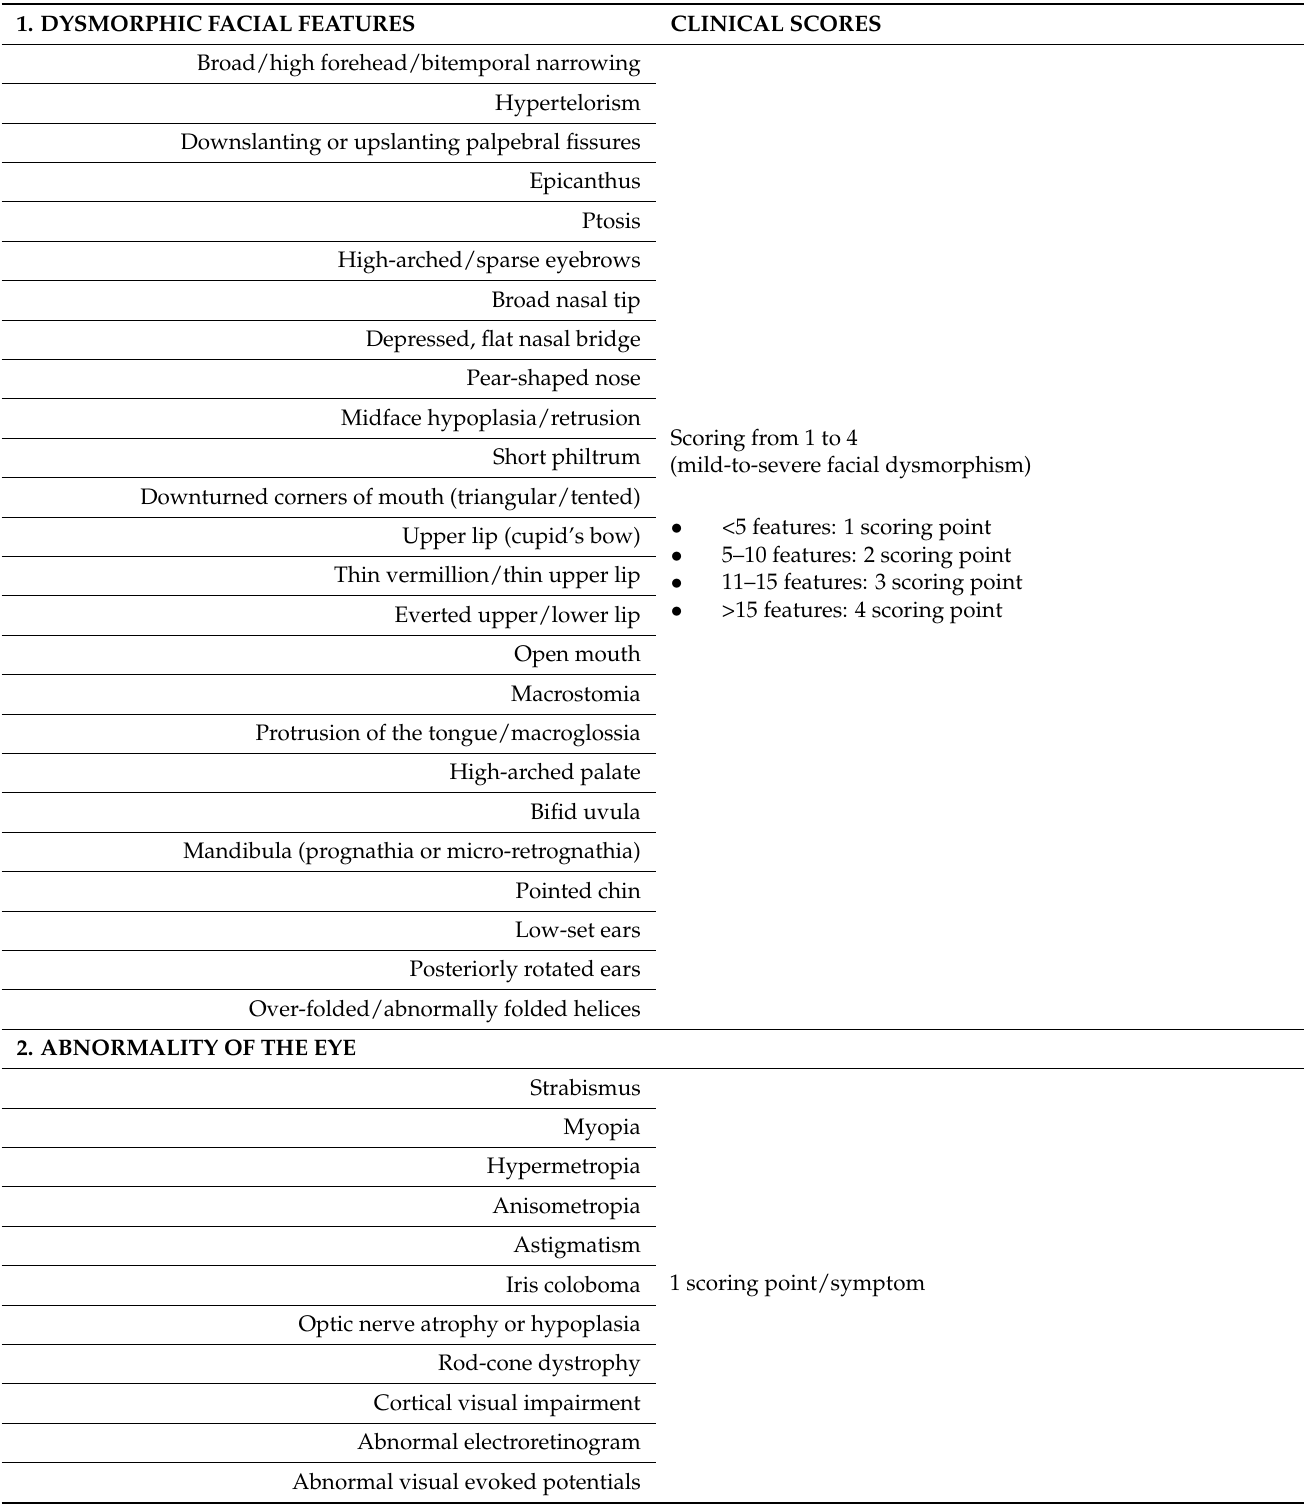
Table 1. Clinical scoring system for the phenotypic features in POGZ